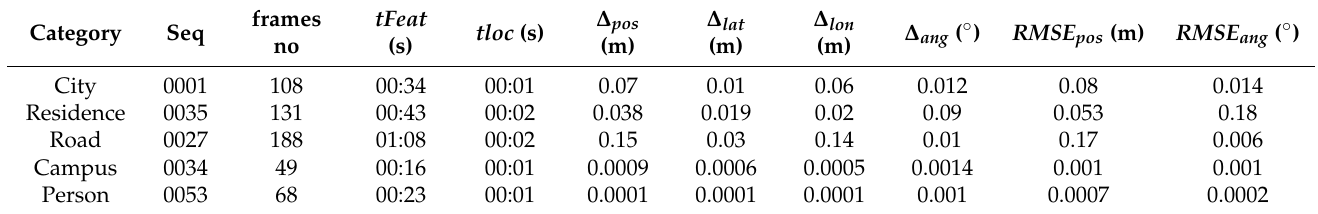
Table 2. Kitti localization error obtained in different categories and the time consumption in each sequence.